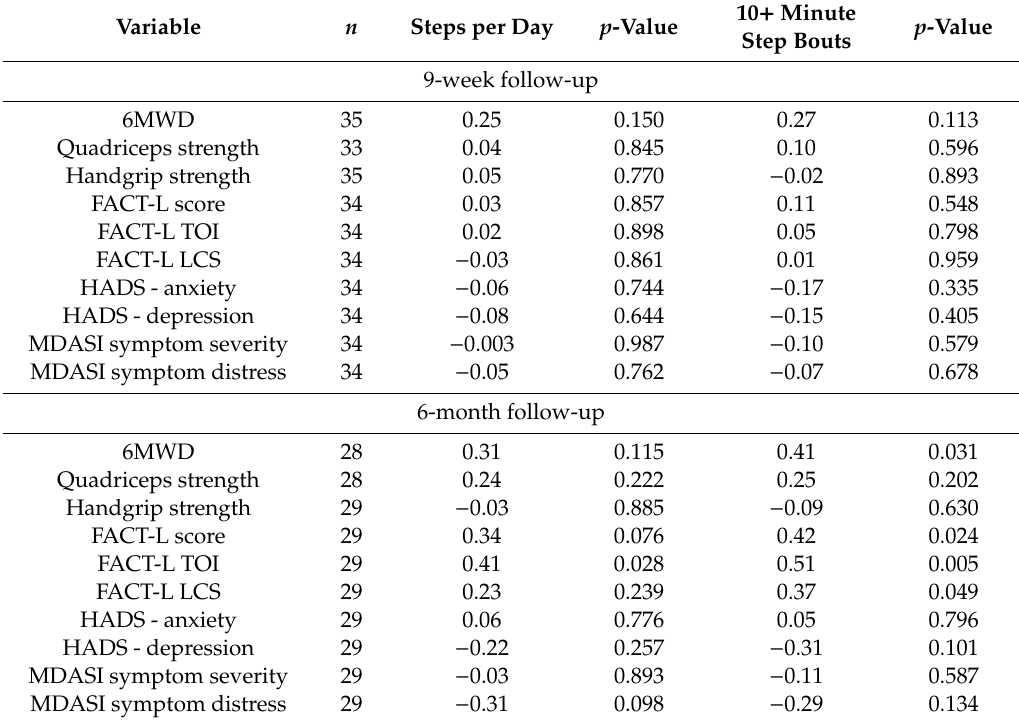
Table 5. Associations between baseline PA and follow-up outcomes for usual care